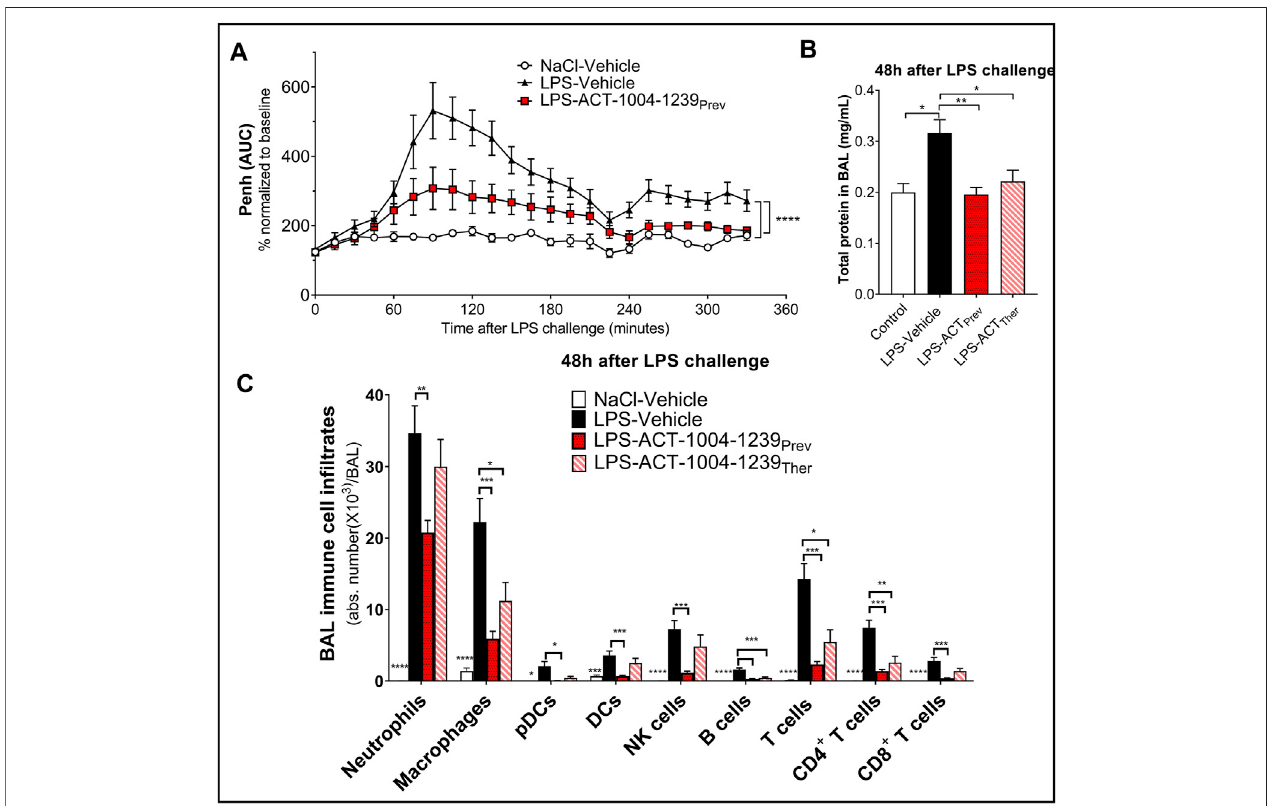
FIGURE 5 | Antagonism of CXCR7 reduces LPS-induced ALI/ARDS. Treatment with the CXCR7 antagonist ACT-1004-1239 signi fi cantly reduced LPS-induced breathingpatternalteration (A) ,alveolar – capillarybarrierpermeability (B) ,andimmunecellin fi ltratesinthebronchoalveolarspace (C) comparedwithvehicle-treated-LPS exposed mice. Mice were treated with vehicle (LPS-vehicle; black) or ACT-1004-1239 (100 mg/kg, LPS-ACT-1004-1239) orally, twice daily, starting 1 h prior to LPS challenge (preventive setting; LPS-ACT Prev ; red) or 3 h after LPS challenge (therapeutic setting; LPS-ACT Ther ; hatched bar). Control mice were treated with vehicle and inhaled NaCl 0.9% (NaCl-vehicle; white). (A) Preventive treatment with ACT-1004-1239 reduced the LPS-induced breathing pattern alteration, measured by the calculated enhanced pause (Penh) using whole-body plethysmography in conscious unrestrained mice over a period of 6 h following LPS inhalation. Results are expressed as the mean percentage Penh area under the curve (AUC) normalized to the baseline ± SEM ( n (cid:1) 8 mice per group). **** p < 0.0001 using two-way ANOVA, followed by Dunnett ’ s multiple comparisons test versus LPS-vehicle-treated mice. (B) Preventive and therapeutic treatment with ACT-1004-1239 reduced alveolar – capillary barrier permeability, measured by a reduction in total protein concentration in BAL supernatant 48 h after LPS challenge ( n (cid:1) 7 – 16 mice per LPS- challenged groups; n (cid:1) 6 NaCl-vehicle control mice). Results are expressed as mean + SEM. * p < 0.05, ** p < 0.01 versus LPS-vehicle-treated mice using one-way ANOVA followed by Dunnett ’ s multiple comparisons test. (C) Preventive and therapeutic treatment with ACT-1004-1239 reduced immune cell in fi ltrates in the BAL, measured by fl ow cytometry 48 h after LPS challenge ( n (cid:1) 7 – 16 mice per LPS-challenged groups; n (cid:1) 6 NaCl-vehicle control mice). Results are expressed as mean ± SEM. * p < 0.05, ** p < 0.01, *** p < 0.001, **** p < 0.0001 versus LPS-vehicle-treated mice using two-way ANOVA followed by Dunnett ’ s multiple comparisons test. The gating strategy for all immune populations is illustrated in Supplementary Figures S1A,B